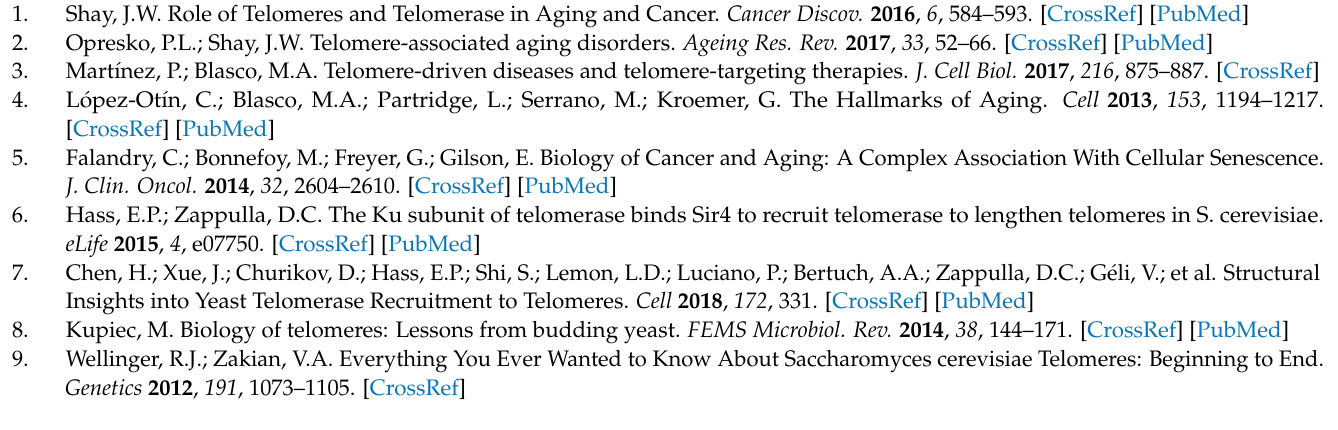
mre11 ∆ sir3 ∆ ; Figure S3: Effects of SIR3 or SIR2 deletion on cell senescence of yku80 ∆ mre11 ∆ cells; Figure S4: Effects of SIR2 , SIR3 or SIR4 deletion on growth of yku80 ∆ mre11 ∆ cells; Figure S5: Tetrad dissection diploid heterozygous for yku80 ∆ mre11 ∆ sir3 ∆ sir4 ∆ ; Figure S6: Effects of SIR3 and SIR4 deletions on cell senescence of yku80 ∆ mre11 ∆ cells; Figure S7: Tetrad dissection of diploid heterozygous for yku80 ∆ , mre11 ∆ sir4 ∆ and rad52 ∆ ; Figure S8: Senescence analysis for yku80 ∆ mre11 ∆ and yku80 ∆ mre11 ∆ sir4 ∆ cell with/without rad52 ∆ or rad59 ∆ ; Figure S9: Tetrad dissection of diploid heterozygous for yku80 ∆ , mre11 ∆ sir4 ∆ and rad51 ∆ ; Figure S10: Tetrad dissection of diploid heterozygous for yku80 ∆ , mre11 ∆ sir4 ∆ and rad59 ∆ ; Figure S11: Tetrad dissection of diploid heterozygous for rif1 ∆ rif2 ∆ mre11 ∆ yku80 ∆ and sir4 ∆ ; Figure S12: Tetrad dissection of diploid heterozygous for rif1 ∆ rif2 ∆ mre11 ∆ yku80 ∆ and sir4 ∆ ; Figure S13: Tetrad dissection of diploid heterozygous for rif1 ∆ rif2 ∆ mre11 ∆ yku80 ∆ and sir4 ∆ carrying pRS315-yku80-135i; Figure S14: Successive streakouts of spores with different genotypes; Figure S15: Effects of Sir4 deficiency on Y (cid:48) element amplification of yku80 ∆ mre11 ∆ cells; Figure S16: Tetrad dissection of diploid strain het- erozygous for yku80 ∆ mre11 ∆ sir4 ∆ ctr9 ∆ ; Figure S17: Tetrad dissection of diploid strain heterozygous yku80 ∆ mre11 ∆ sir4 ∆ ctr9 ∆ ; Figure S18: BY4743 YKU80 / yku80 ∆ ::natNT2 MRE11 / mre11 ∆